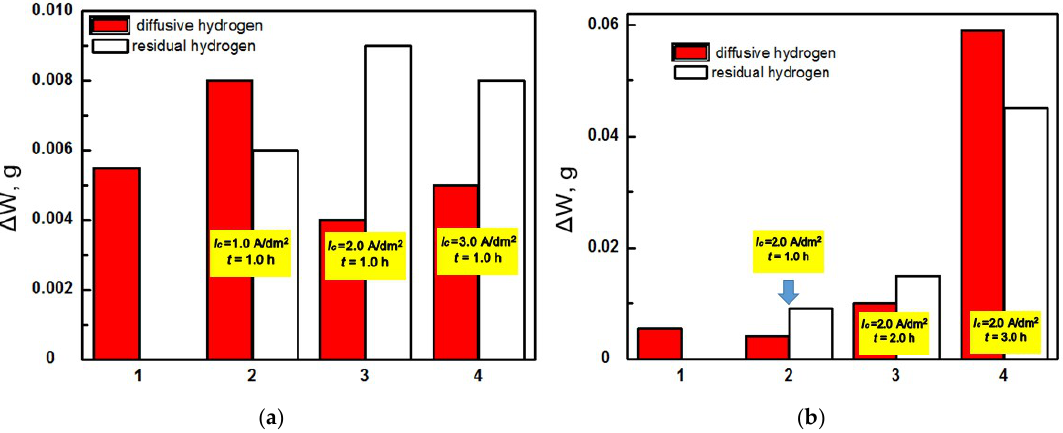
Figure 4. Weight losses of specimens from steel 45, taking into account preliminary hydrogenation at a current density of 1.0 A/dm 2 ( a ) and 2.0 A/dm 2 ( b ) during their tribocontact with the PEO layer synthesized on the AMg-6 alloy, determined by testing in mineral oil I-20 by contact load 4.0 MPa; 1—without preliminary hydrogenation; 2–4—taking into account hydrogenation (hydrogenation parameters are shown on columns).